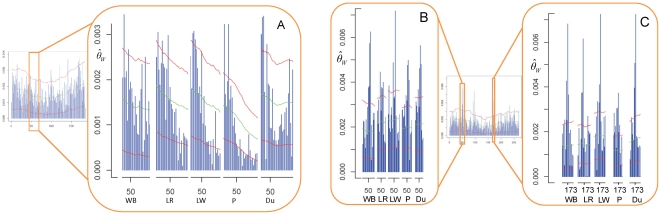
Variation of  along the wild boar SSC8 and SSC7.Blue bars represent point estimates for each 500 Kb window. Red lines represent confidence interval limits with a significance level of 95%. Green lines represent the average  per window. The insets are enlargements of the orange boxes that show details of the variation of  in genomic regions that deviate from the standard neutral model in all sampled populations. A- Detail of genomic regions with a significantly low  and that potentially contains the KIT gene. B- Detail of genomic regions with a significantly high  and that potentially contains the TRIM26 gene member of the SLA locus. C- Detail of genomic regions with a significantly low  and that potentially contains the OR4K13 gene.